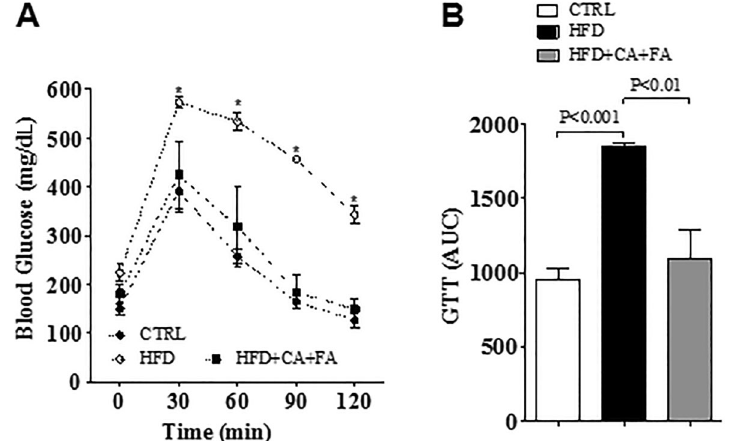
Figure 3. Effect of a high-fat diet (HFD) with combined treatment of caffeic acid (CA) and ferulic acid (FA) (0.9 and 50 mg (cid:3) kg – 1 (cid:3) day – 1 , respectively) on glucose metabolism. A , Blood glucose levels before and after intraperitoneal glucose tolerance test with administration of 2 g/kg glucose. B , Area under curve (AUC) of the glu- cose tolerance test (GTT) of all groups. Data are reported as means ± SEM of fi ve animals per group. *P o 0.01 vs CTRL (ANOVA followed by the Student Newman-Keuls test).